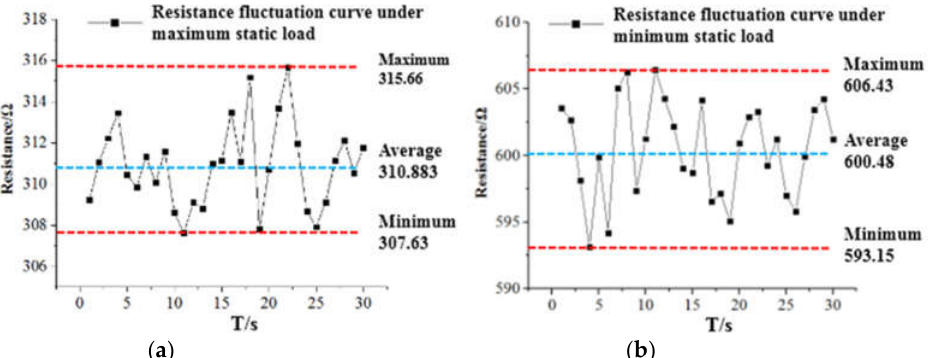
Figure 9. Resistance change diagrams for static extreme load. ( a ) Resistance change diagram at 10 kN. ( b ) Resistance change diagram at 60kN.